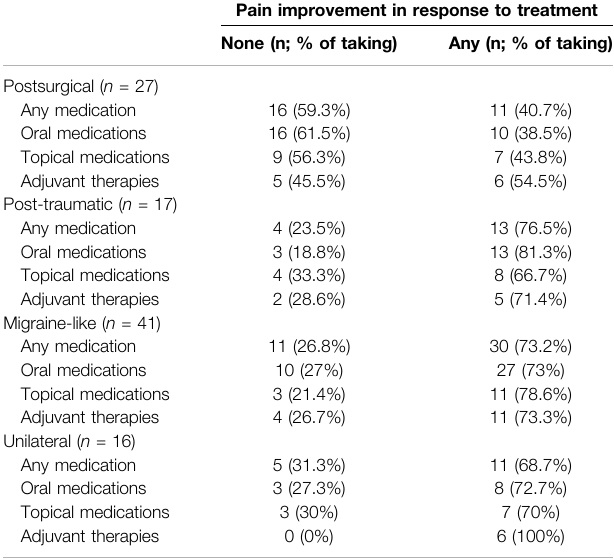
TABLE 3 | Proportion of medications that led to improvement in pain, by pain